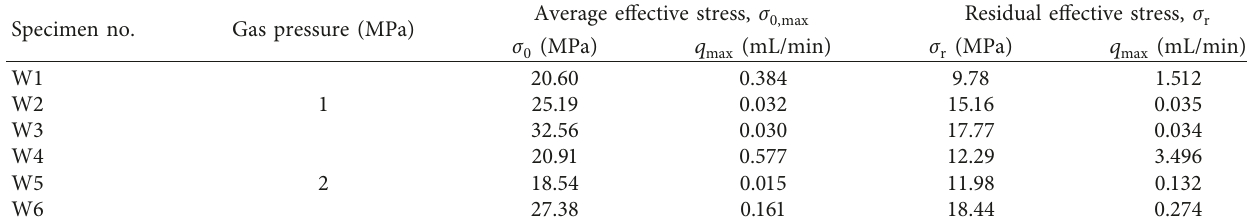
Table 2: Test parameters of average effective stress-seepage velocity. Specimen no.